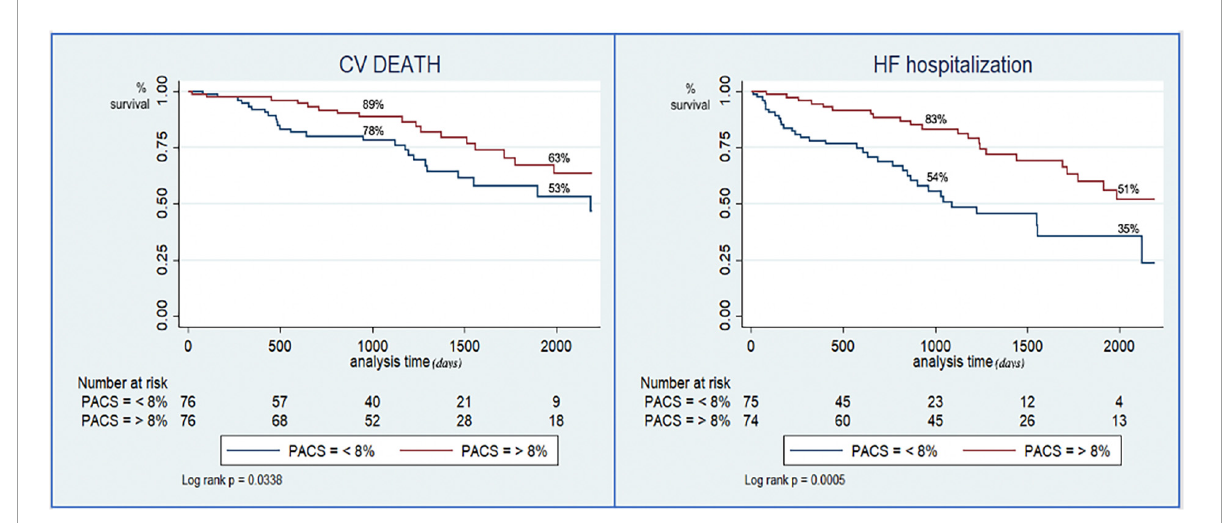
FIGURE2 Kaplan–Meier curves for the risk stratification of cardiovascular death (left) and hospitalization for heart failure (right) based on preserved or reduced peak atrial contraction strain